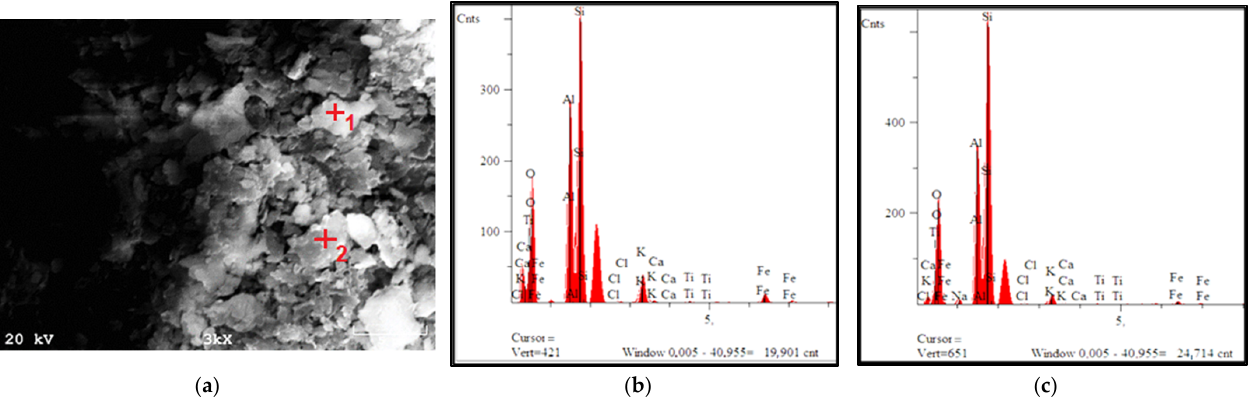
Figure 9. Particle morphology: ( a ) material after calcination (before synthesis and modification); ( b ) qualitative chemical analysis at point 1; ( c ) qualitative chemical analysis at point 2.